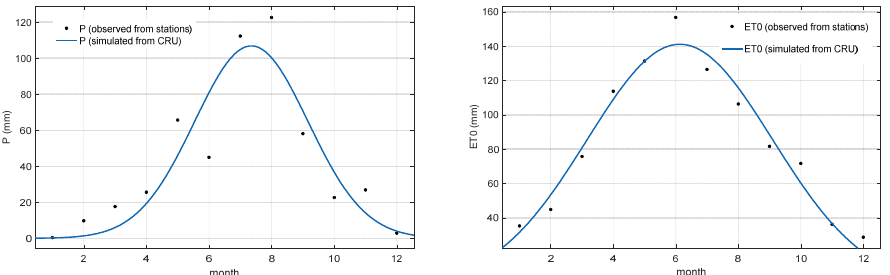
Figure 2. Average monthly areal precipitation and ET 0 in Yellow River basin during 1951–2017.